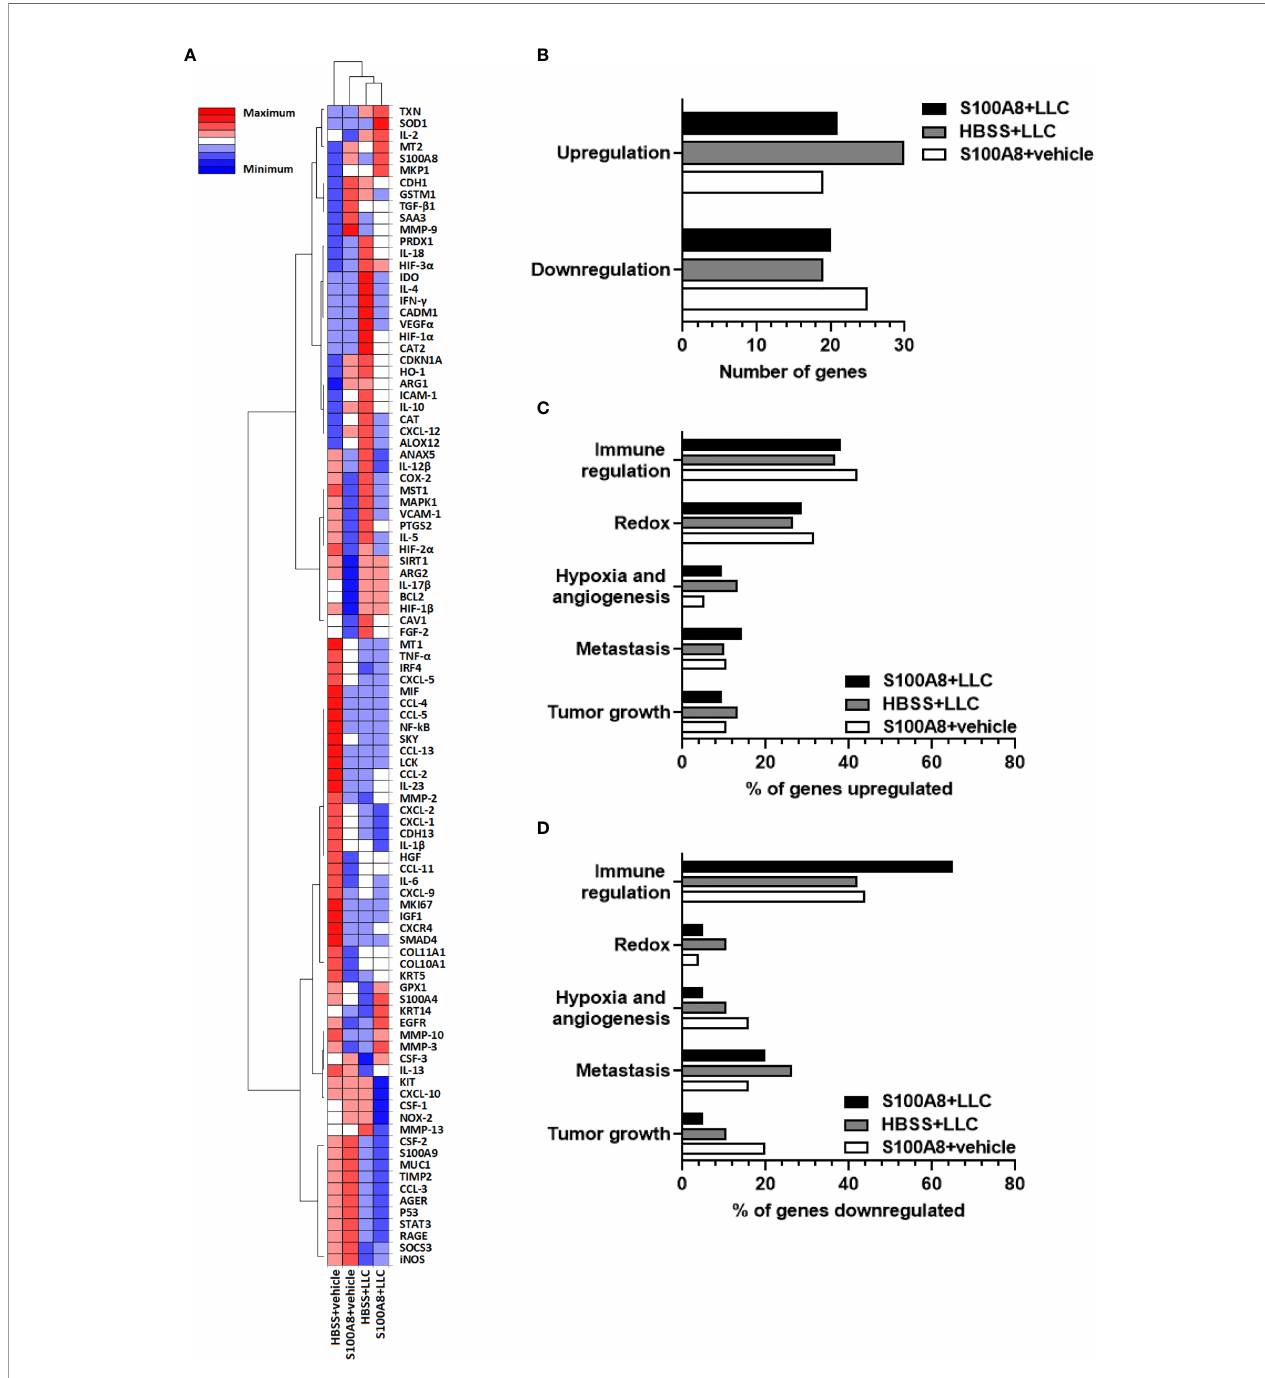
FIGURE 2 | Expression pro fi les of genes in mouse lungs following intranasal S100A8 treatments. (A) Clustergram showing expression of 98 genes in whole lung tissue collected from mice treated intranasally with mouse recombinant S100A8 (10 µg) or HBSS 3, 6 and 9 days post-LLC cell implantation (S100A8 + LLC and HBSS + LLC) and harvested on Day 10. Mice without LLC tumors treated with S100A8 (10 µg) or HBSS served as controls (S100A8 + vehicle and HBSS + vehicle groups). Data from non-supervised hierarchical clustering of the entire data set were combined to display a heatmap with dendrograms indicating co- regulated genes in each treatment group, n = 4-5 mice per treatment group. Increasing intensity of red denotes upregulation by 0.3-fold to 2-fold; maximum denotes changes > 2-fold. Increasing intensity of blue denotes downregulation by 0.3-fold to 2-fold; maximum denotes changes > 2-fold. (B) Graph showing total number of genes upregulated or downregulated in each treatment group compared to HBSS + vehicle group. (C, D) Graphs showing percentages of genes involved in immune regulation, redox, hypoxia and angiogenesis, metastasis, and tumor growth that were (C) upregulated or (D) downregulated in each treatment group compared to HBSS + vehicle